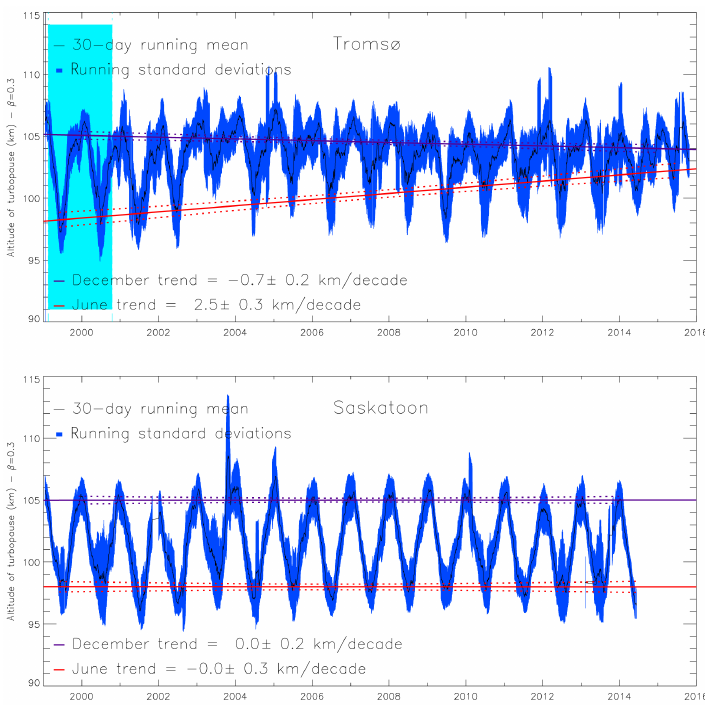
Figure 1. Turbopause altitude as determined by the definition and method described in this paper. The thick solid line shows the 30-day running mean and the shading behind it the corresponding standard deviations. The straight lines show the fits to summer and winter portions of the curve. Upper panel: 70 ◦ N (Tromsø); lower panel: 52 ◦ N (Saskatoon). The cyan background in the 70 ◦ N panel indicates data available but unused here due to different experiment parameters.